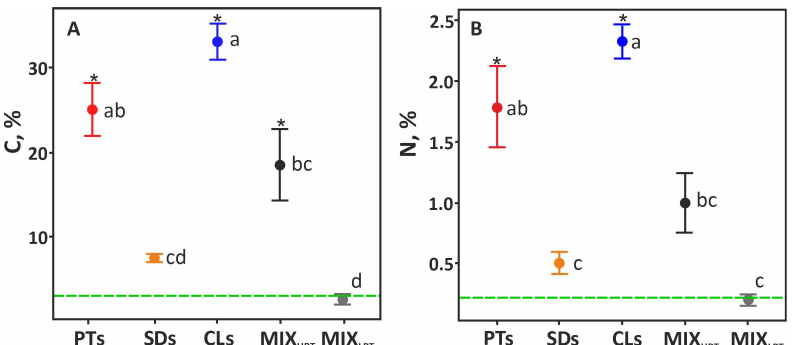
Figure 1. Mean (circles) and standard errors (bars) of total carbon ( A ) and nitrogen ( B ) in peats (PTs), sediments (SDs), cultural layers (CLs), high-peat (MIX HPT ) and low-peat (MIX LPT ) mixtures. Dotted green line represents the mean for the natural soil reference. Letters indicate the significantly different groups (Tukey’s test). Means with * indicate a significant difference from the natural soil (Dunnett’s test).